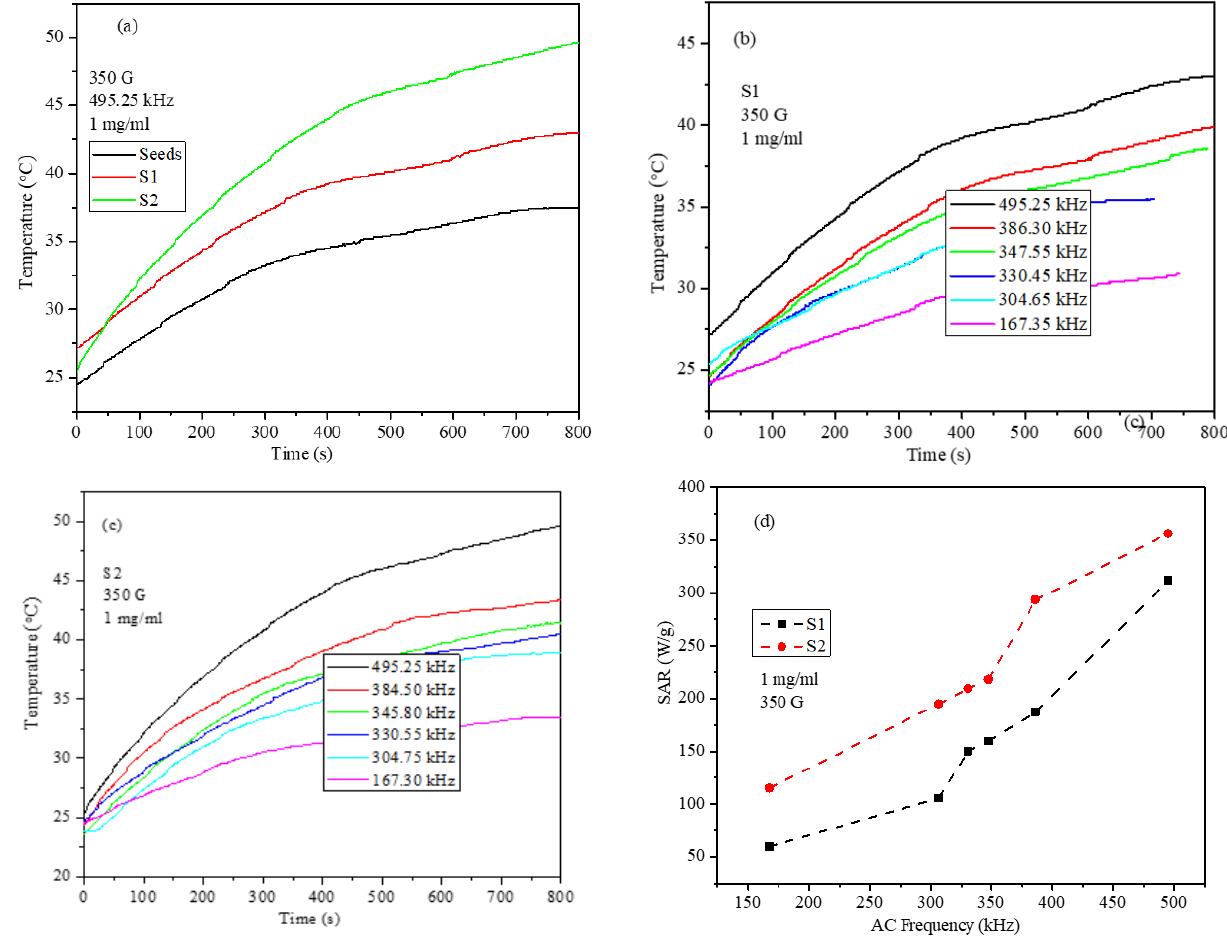
Figure 10. ( a ) Heating profiles of the seed, S1, and S2 core-shell nanoparticles at 495.25 kHz and a 350 G field strength, ( b ) frequency-dependent heating profiles of the S1 (1 mg/mL) nanoparticles under 350 G, ( c ) frequency-dependent heating profiles of the S2 (1 mg/mL) nanoparticles under 350 G, and ( d ) frequency-dependent SAR values of the S1 and S2 nanoparticles under a 350 G AC field in the frequency range of 495.25–167.30